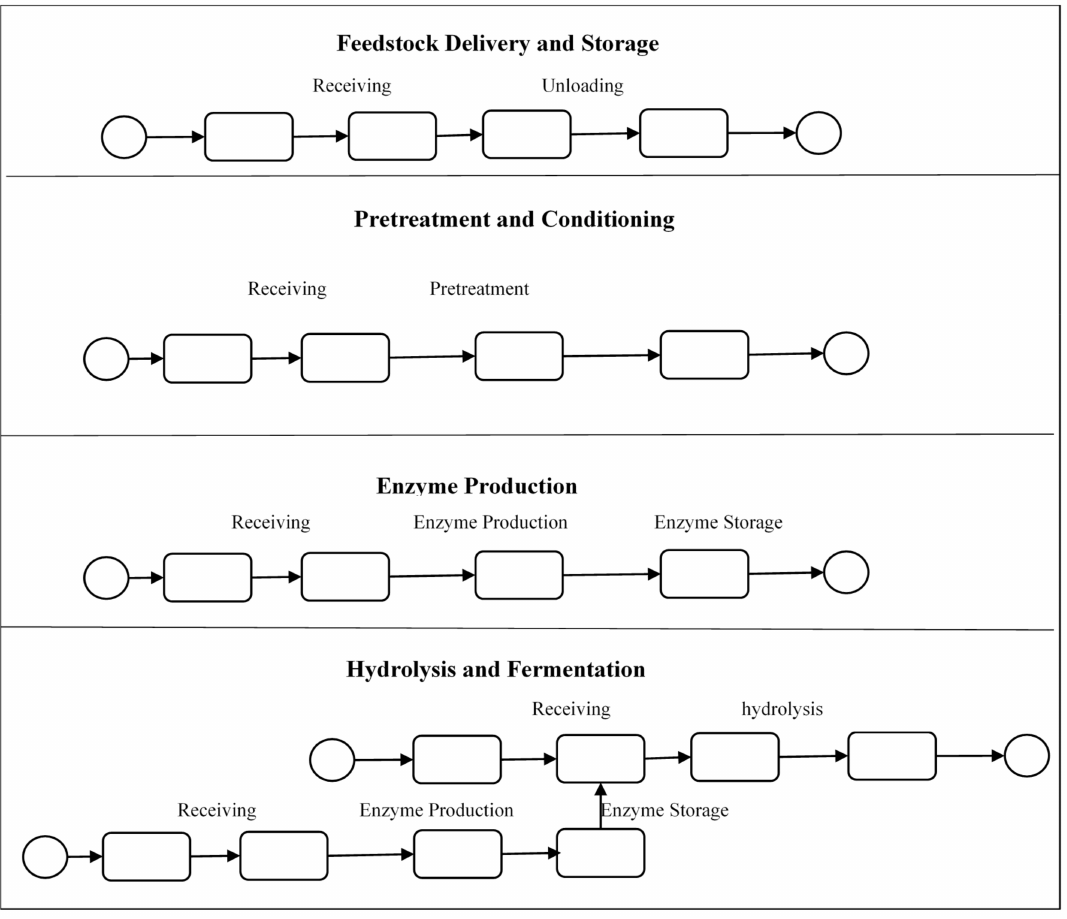
Figure 2. Biofuel refinery process.